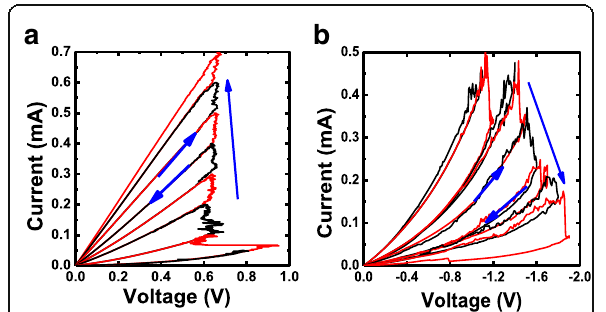
Fig. 3 Robust multilevel resistance states behaviors to the disturb voltage pulses with the amplitudes of 0.7 V/ − 1.0 V and the width ranging from 10 ns to 1